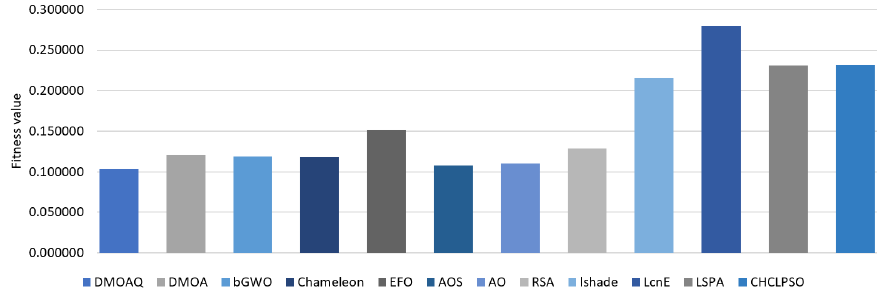
Figure 2. Average of values of the fitness